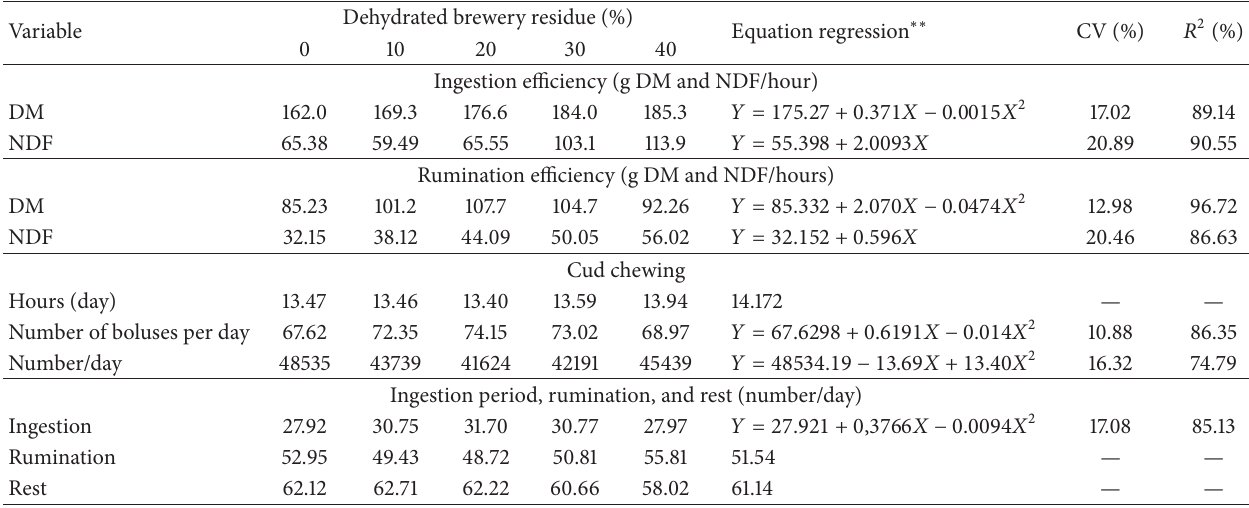
Table 3: Feeding efficiency (g DM and NDF/hour), rumination efficiency (g DM and NDF/hour), cud chews, and number of meal periods, rumination, and rest (number/day) of ovine fed with marandu grass silage.